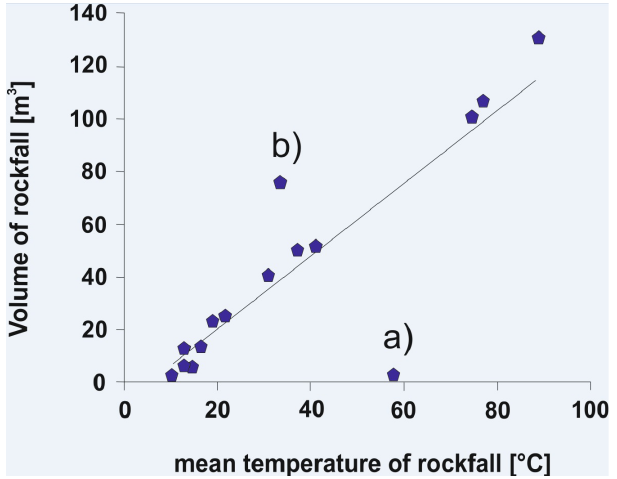
Fig. 7. Relationship between the volume of rockfalls estimated from photos taken before and after and the mean temperature of the re- lated deposits distributed over the volcano’s slope. Two outliers can be observed: point (a) marks a rockfall that happened shortly after a large one so the high average T for the observed small volume is not representative. Point (b) marks a rockfall that broke off from the NW edge of the dome. Here rockfall activity was very low; accord- ingly the involved mass had had more time for cooling, leading to the observed low value of average T .